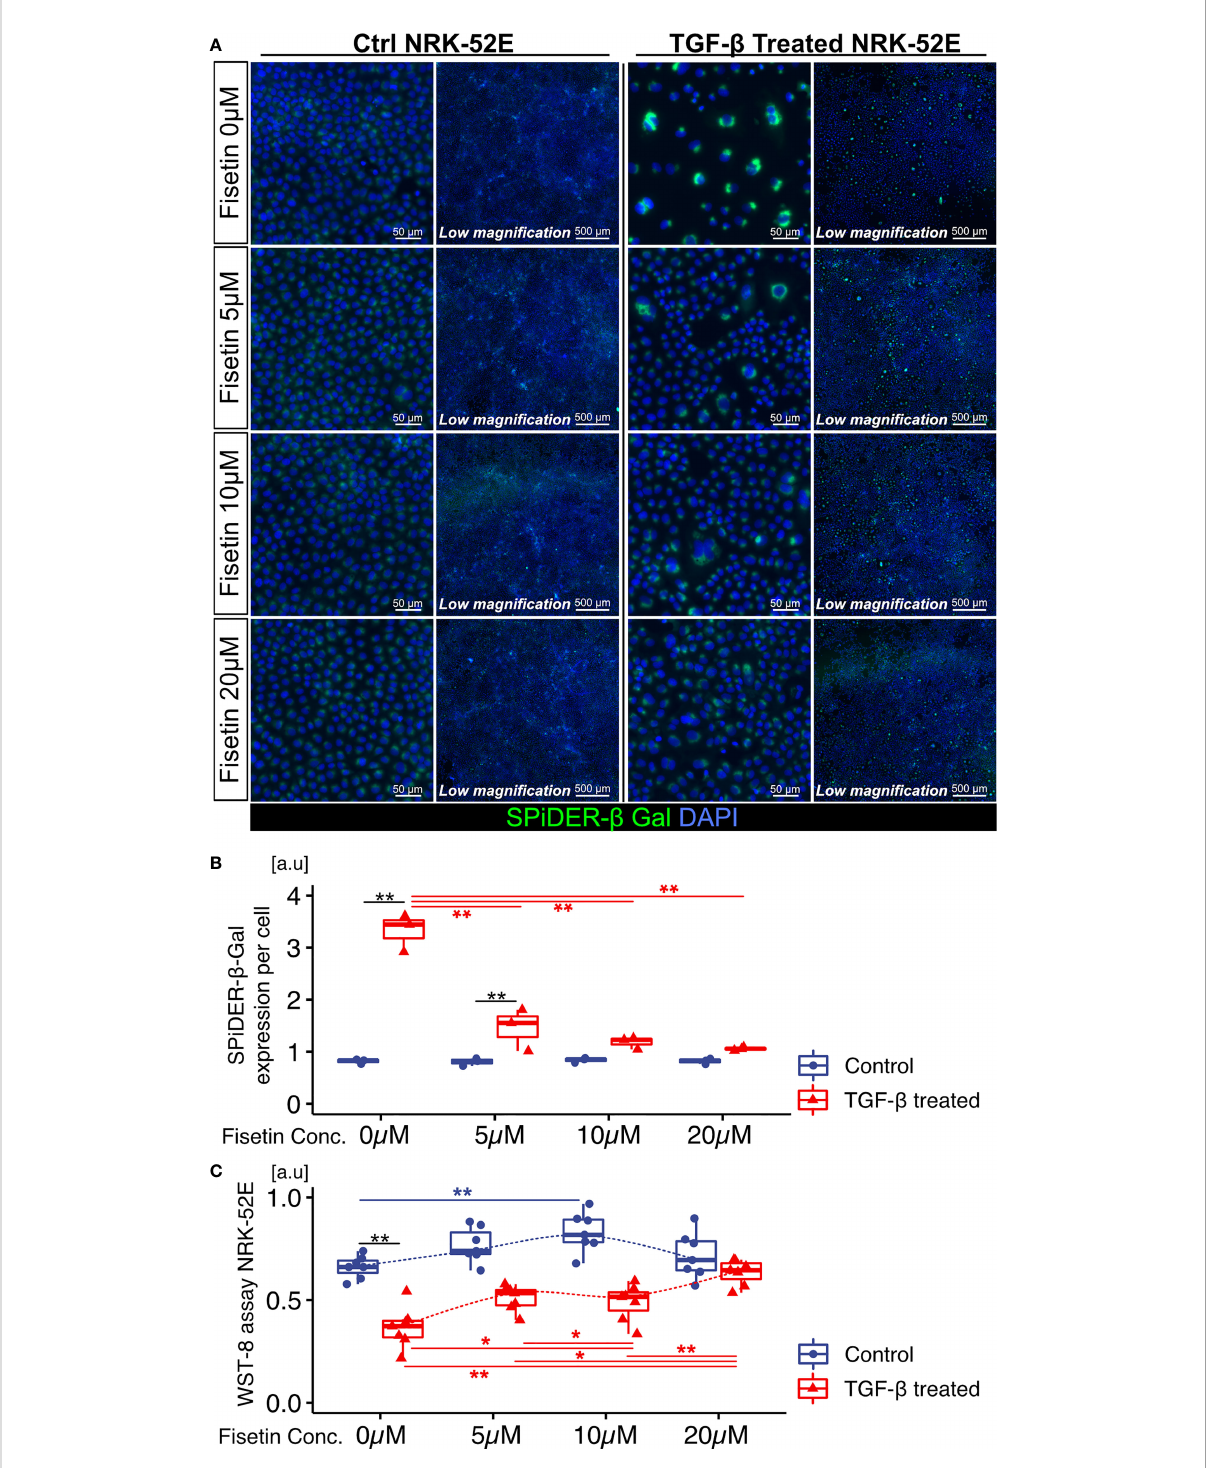
FIGURE 3 Fisetin treatment reduces the number of SPiDER- b -Gal – positive cells in TGF- b 1 – treated senescent renal tubular cells. (A) Representative images of SPiDER- b -Gal staining in TGF- b 1 – treated senescent NRK-52E cells with and without fi setin treatment (0, 5, 10, 20 µM). (B) Quanti fi cation of SPiDER- b -Gal expression levels in NRK-52E cells measured based on fl uorescence intensity. (C) WST-8 cell proliferation assay in NRK-52E cells after TGF- b 1 and fi setin treatment. P -values were determined using two-way ANOVA adjusted by Tukey ’ s method (*P < 0.05 and **P <